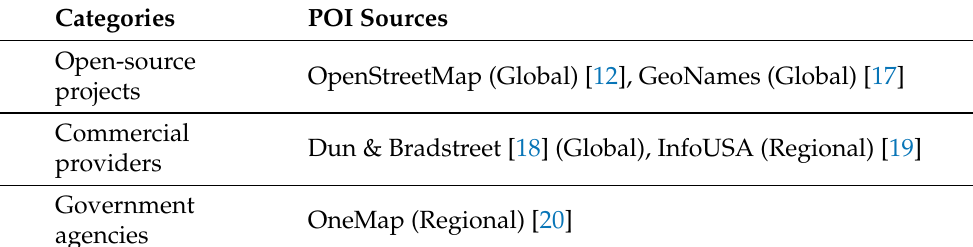
Table 1. Examples of POI data sources grouped based on four different categories: open-sourced projects, commercial data providers, government agencies, and LBSNs. Each data source is tagged correspondingly to indicate whether it provides global or regional